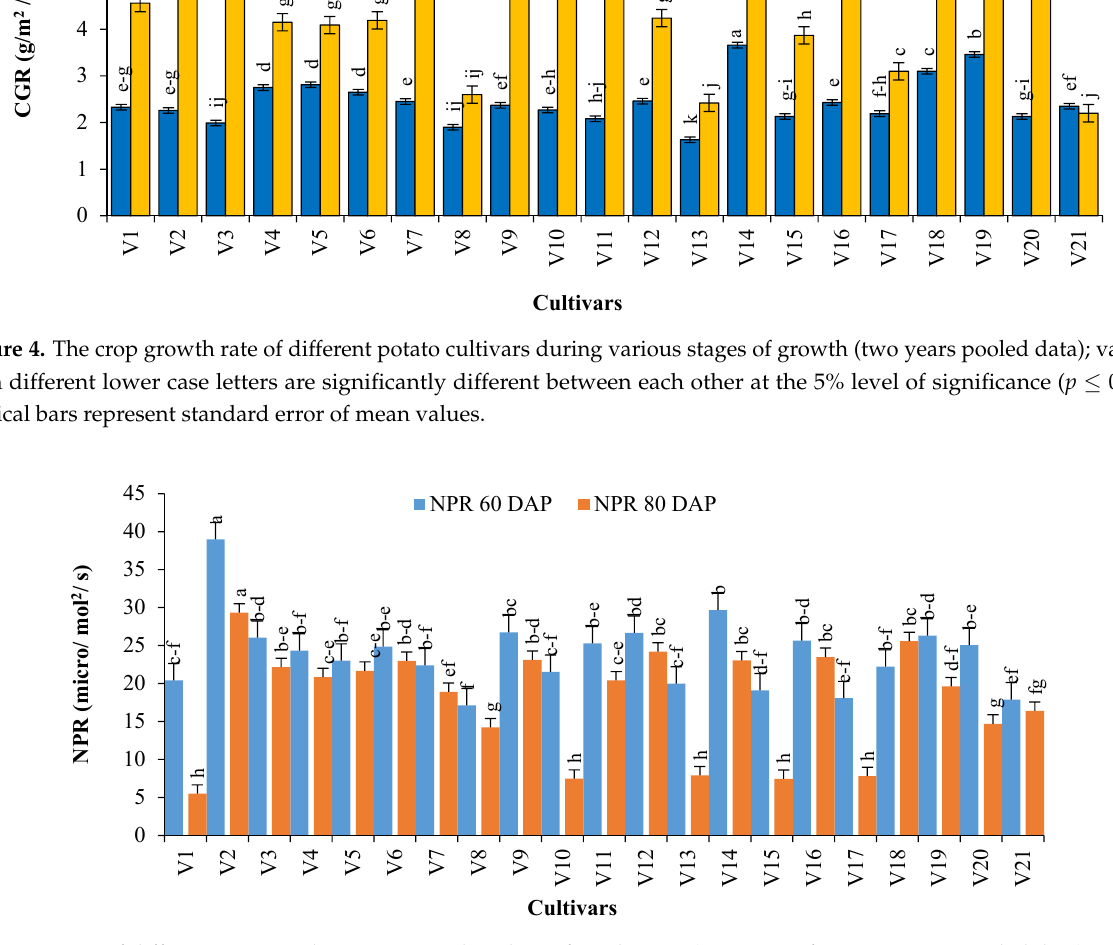
Figure 5. NPR of different potato cultivars at 60 and 80 days after planting (estimation from two years pooled data); values with different lower case letters are significantly different between each other at the 5% level of significance ( p ≤ 0.05); vertical bars represent standard error of mean values.